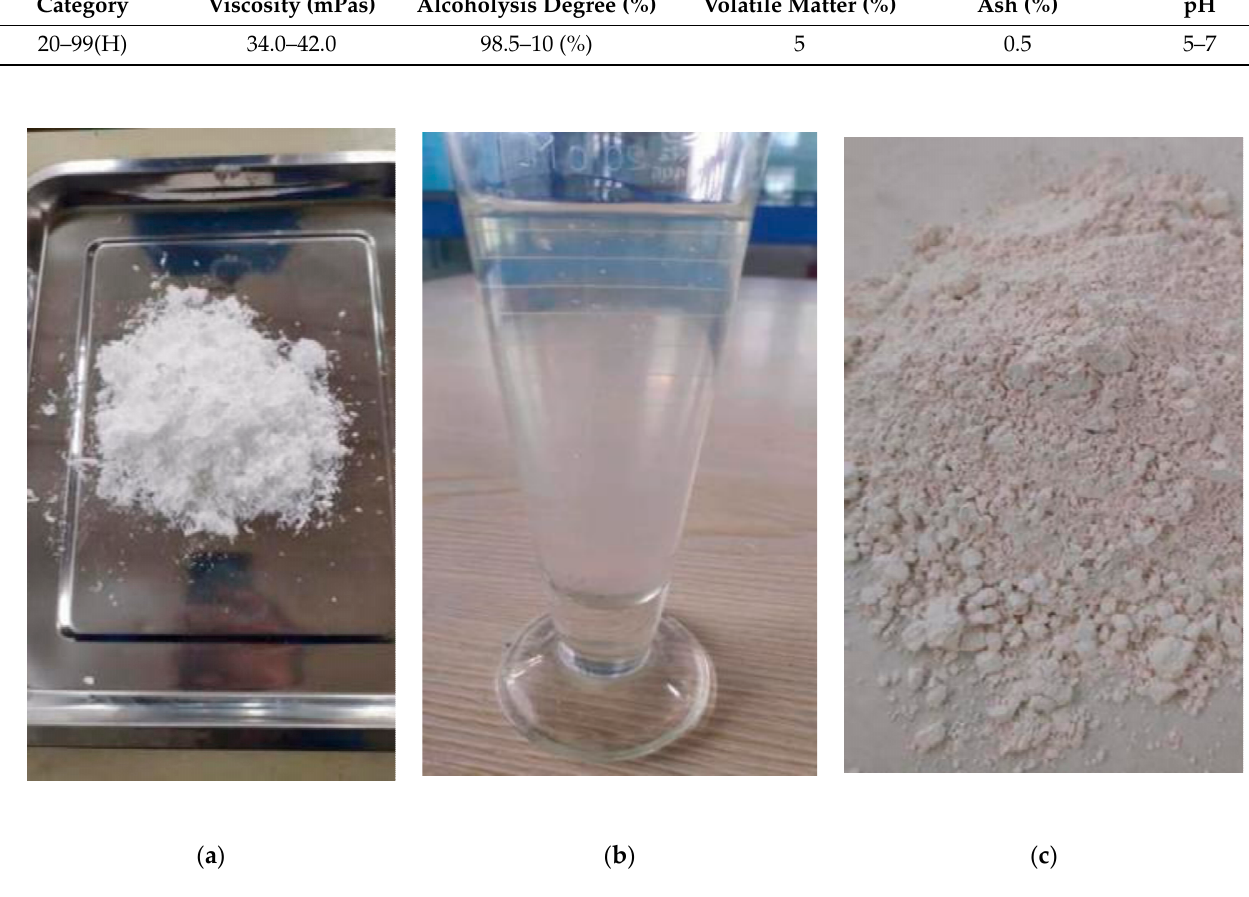
Table 1. Basic properties of polyvinyl alcohol (PVA).